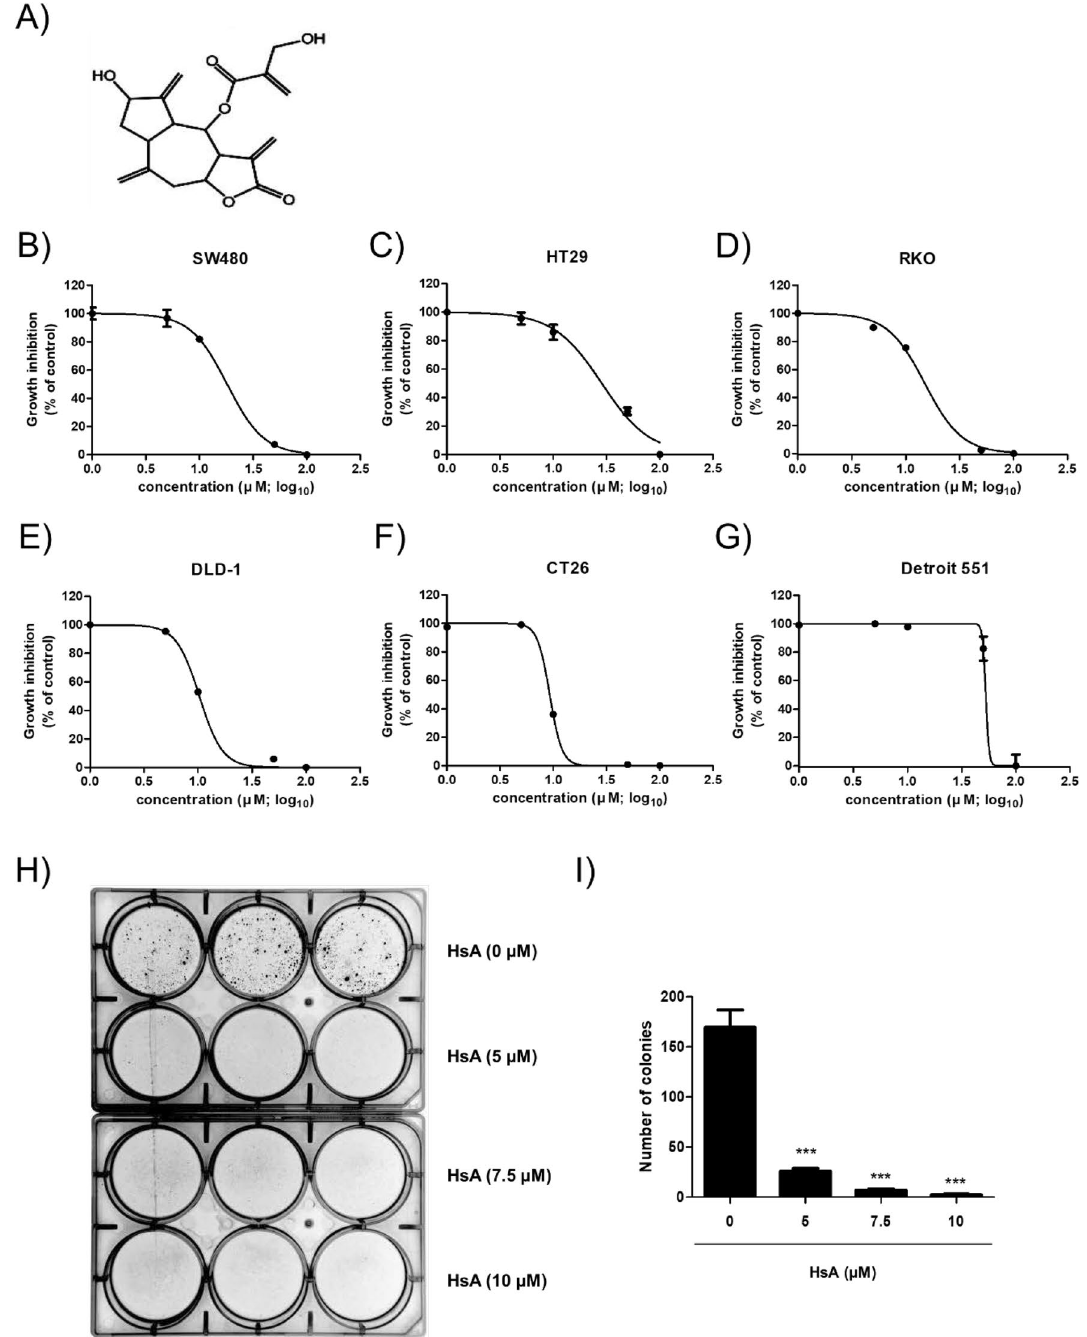
Figure 1. Chemical structure and cytotoxic effect of HsA. ( A ) The chemical structure of HsA (CID: 10043230). ( B – G ) SW480 ( B ), HT29 ( C ), RKO ( D ), DLD-1 ( E ), CT26 ( F ), and Detroit 551 ( G ) cells were treated with the indicated concentrations of HsA (0, 1, 5, 10, 50, 100 μM) for 24 h. The cytotoxic effects of HsA were measured by MTT Assay. All results were shown as log concentration calculating IC50from a dose–response curve compared with the control group. ( H ) DLD-1 cells were cultured with HsA (0, 5, 7.5, 10 μM) for 2 weeks, and colonies were analyzed. Results are presented as means ± SEM. ***p < 0.001, compared to the